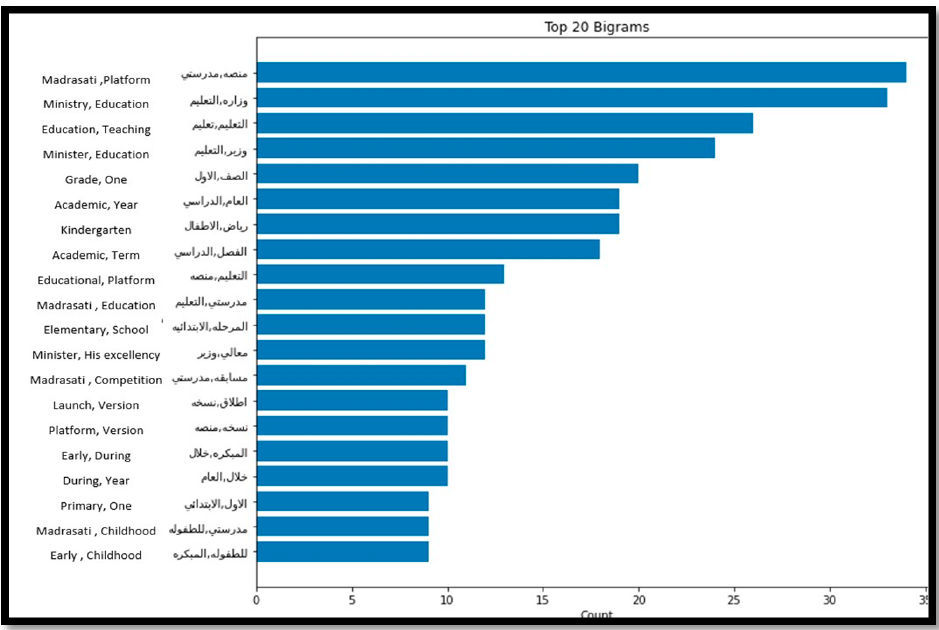
Figure 9. Top 20 Frequent words from the primary schools’ and kindergartens’ positive tweets.